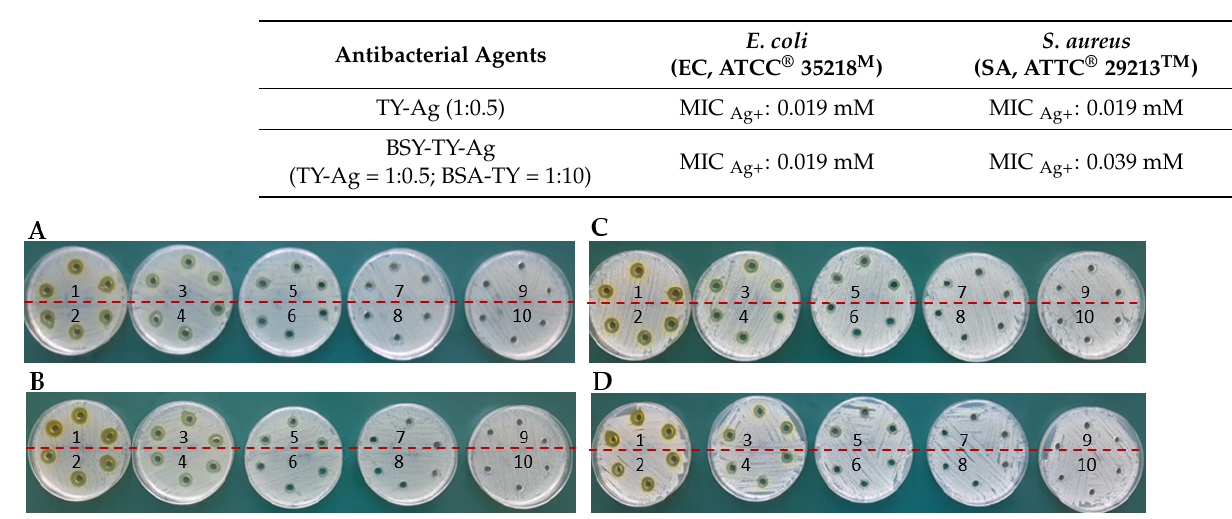
Table 2. Minimum Inhibitory Concentration (MIC) of silver in complexes with TY or with BSA-TY in different molar ratios for two reference strains: E. coli and S. aureus determined with agar diffusion method.